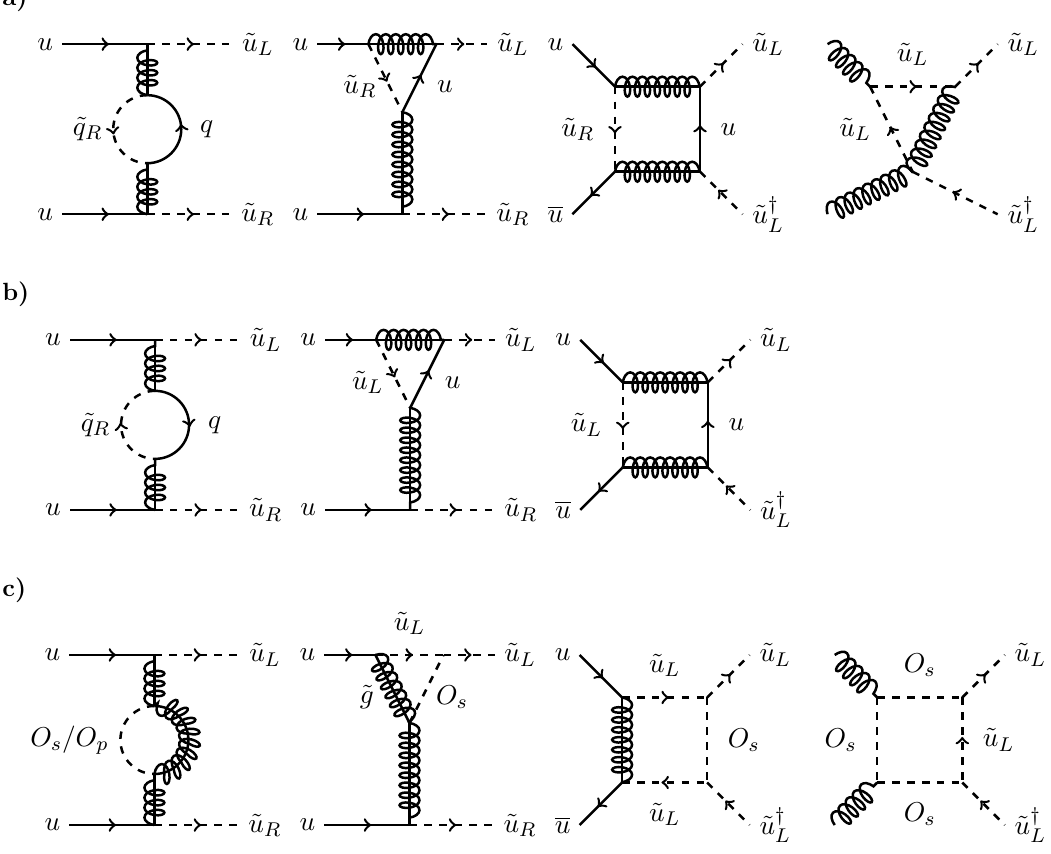
Figure 4. Examples of Feynman diagrams relevant for the NLO corrections to ~ q ~ q and ~ q ~ q y produc- tion. Categories as in (cid:12)gure